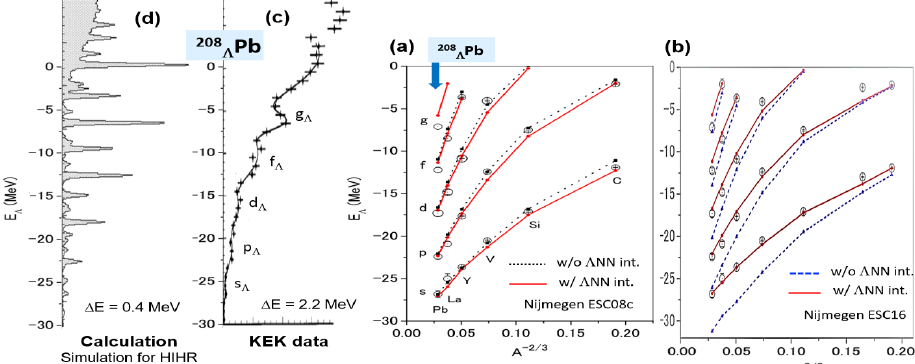
Figure 1. (a) B Λ values of various Λ ’s single particle states for a wide range of hypernuclear mass number A calculated using the ESC08 interaction [2], without and with the universal 3BF for Λ NN . Experimental data are shown in inside circles. (b) The same as (a) but the ESC16 interaction is used [3]. (c) 208 Λ Pb spectrum measured at KEK [4] shown together with the figures (a) and (b). (d) Simulated 208 Λ Pb spectrum expected in the proposed experiment at HIHR [5] based on a theoretical